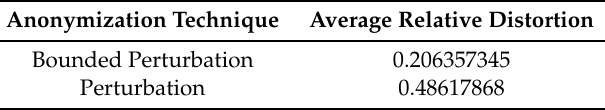
Table 2. Average relative distortion for PoIs .